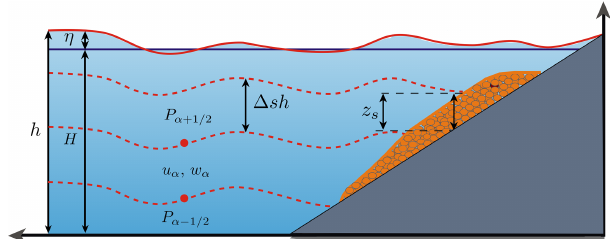
Figure 5. Schematic figure to describe the multilayer system, with water height ( h ), unchanged non-erodible bathymetry ( H ), depth- averaged velocity in the x direction ( µ α ), depth-averaged veloc- ity in the z direction ( ω α ), sediment thickness ( z s ), non-hydrostatic pressure at the interface ( Pα − 1 / 2), free-surface elevation measured from a fixed reference level ( η ) and the number of layers ( L